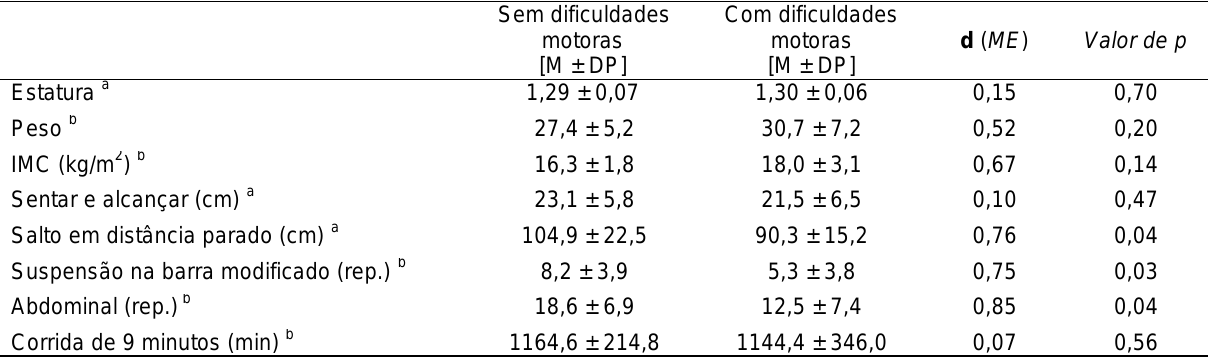
Tabela 2. Média e desvio padrão nas variáveis relacionadas à aptidão física para os grupos com e sem dificuldades